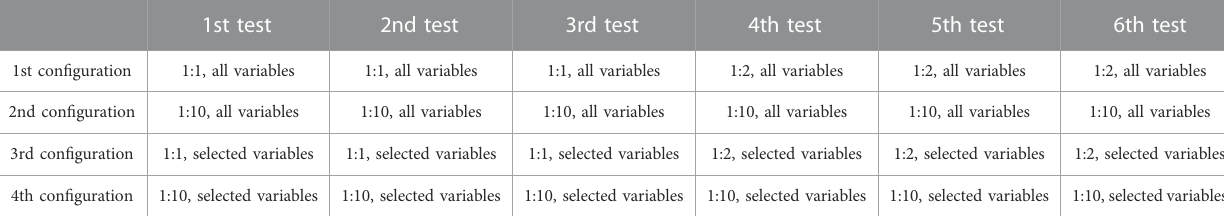
TABLE 2 Summary table of the four con fi gurations used in the proposed methodology, summarizing the ratio between training and test samples and the number of independent variables used as input for the RF